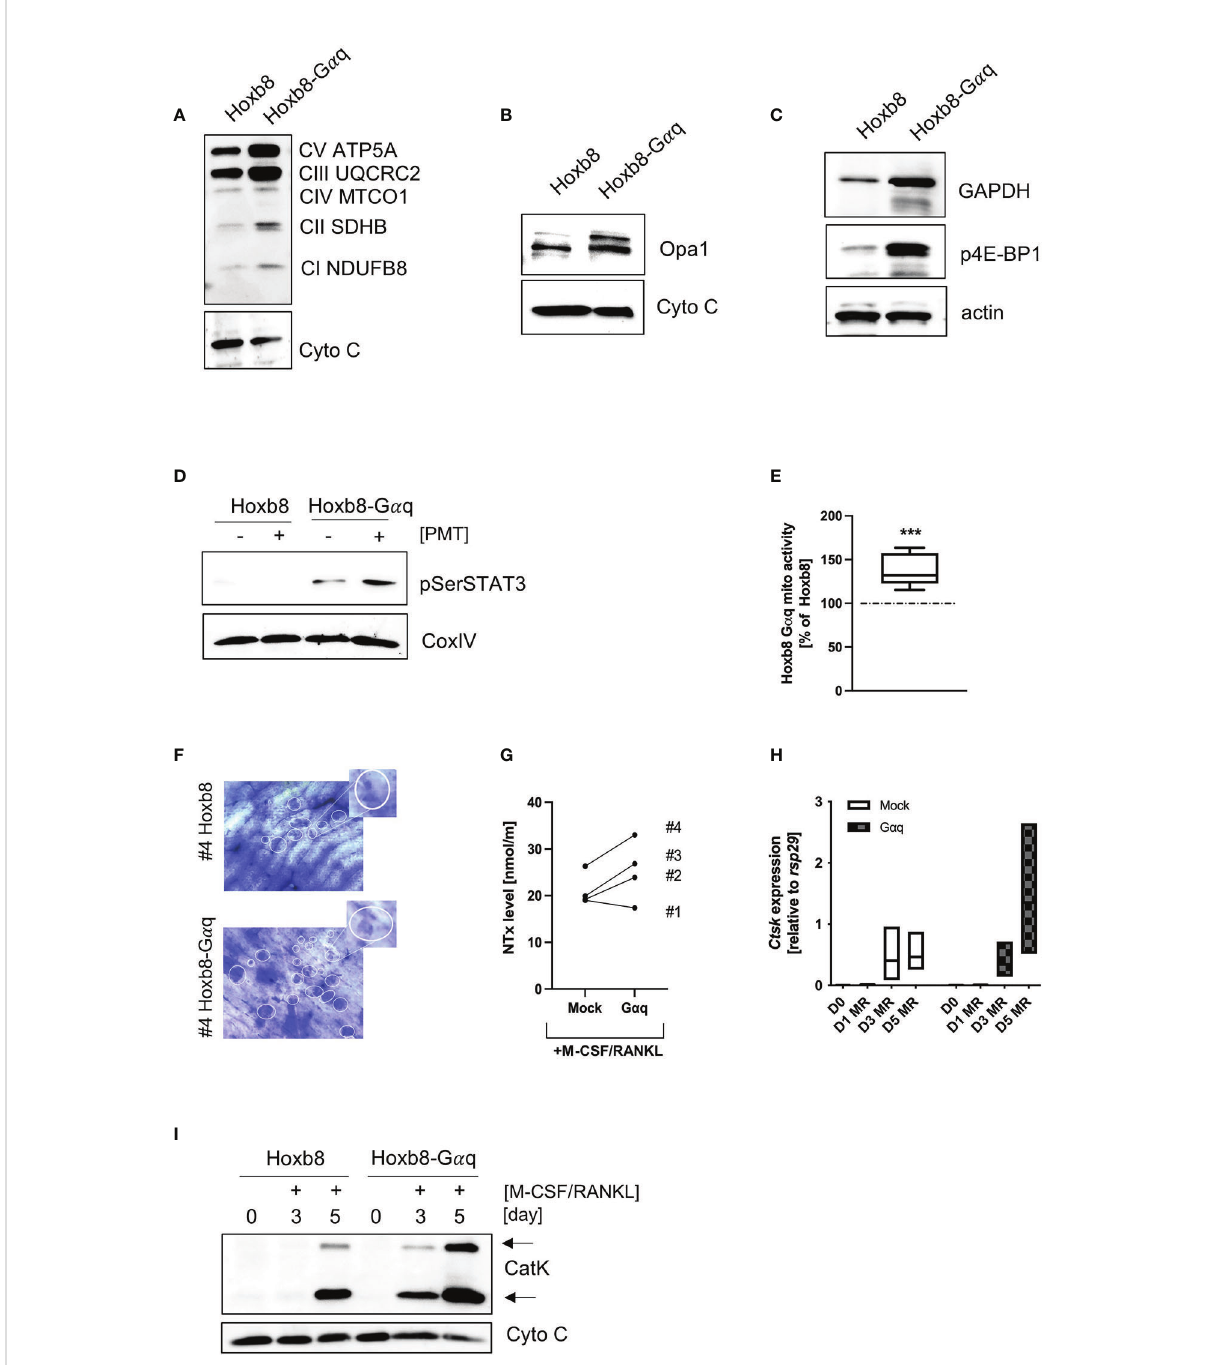
FIGURE 6 Overexpression of G a q in ER-Hoxb8 cells mimics the hypermetabolic phenotype. Lysates from mock-transduced and G a q-transduced ER- Hoxb8 cells were probed for the expression of OxPhos components (A) , OPA1 (B) , GAPDH and p4E-BP1 (C) . Cytochrome C and actin were used as controls (n=3). (D) ER-Hoxb8 and ER-Hoxb8-G a q cells were left untreated or stimulated with 1 nM PMT for 3 hours before lysis. Lysates were probed for pSer STAT3; COXIV was used as a lysate control (n=3). (E) Mitochondrial activity was quanti fi ed by Mitotracker Deep Red analysis and subsequent evaluation of m fi values (n=5). Statistical analysis was done performing a Wilcoxon test on the raw data before normalisation to ER-Hoxb8 as 100%. (F) Bone slices were incubated for 14 days with ER-Hoxb8 and ER-Hoxb8-G a q cells before staining the bone with toluidine blue. The bone slices shown correspond to #4 of the ELISA shown in (G) , where the supernatants from the bone slices were used to quantify the released collagen (day 3) (H) RT-PCR analysis of ER-Hoxb8 and ER-Hoxb8-G a q cells for Ctsk induction normalised to rsp29 on days 0, 1, 3 and 5 (n=3). (I) Western Blot analysis of cell extracts from ER-Hoxb8 and ER-Hoxb8-G a q cells of days 0, 3 and 5 and detection of immature and mature forms of Cathepsin K, using Cytochrome C as a control for equal loading